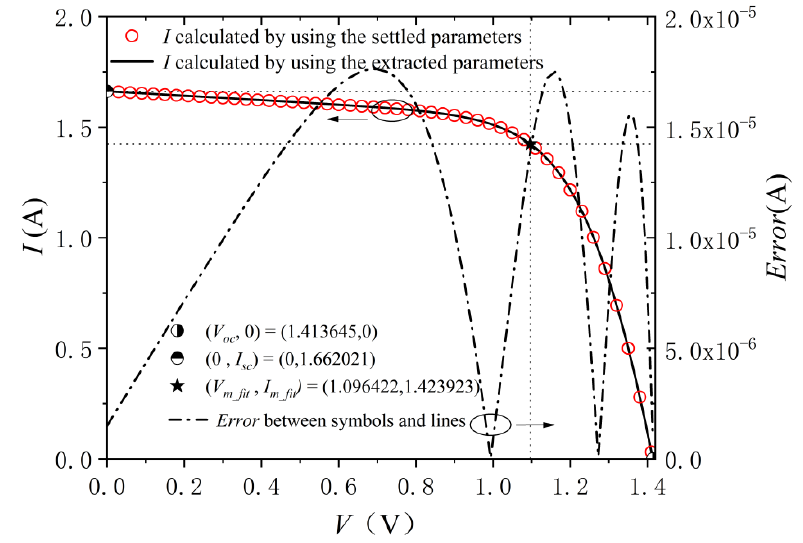
Figure 2. Comparison of calculated I-V characteristics with the settled and estimated parameters shown in Table 1, and the absolute errors between symbols and lines.